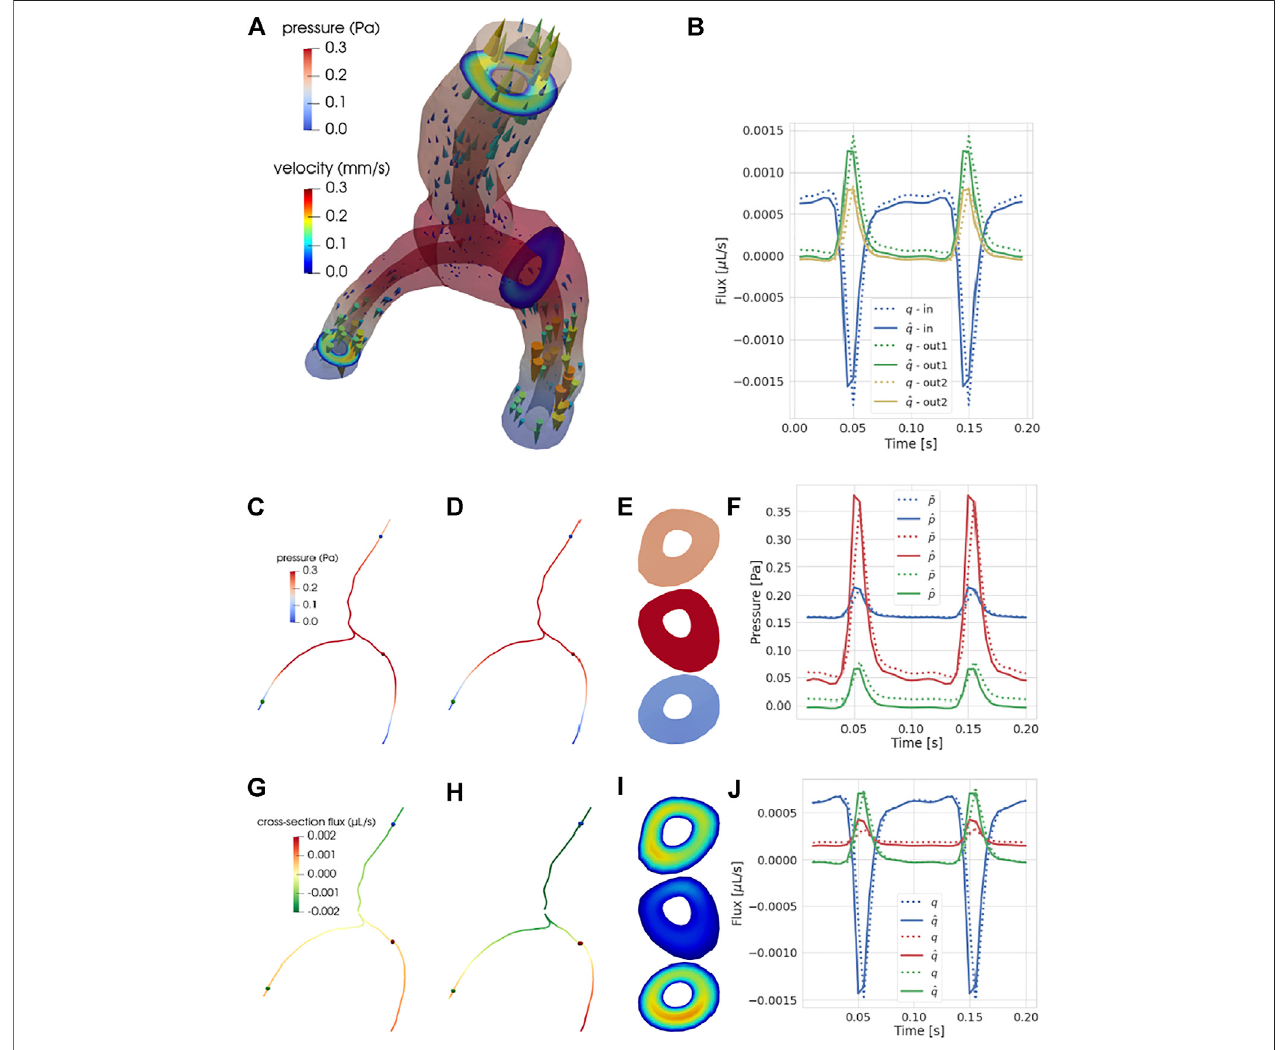
FIGURE 6 | Flow through a bifurcating PVS (Model C12) (A) Snapshot of pressure and velocity from full model at peak velocity ( t = 0.05). (B) Full versus reduced cross-section fl ux at inlet (in) and outlets (out1 and out2) over time. (C) Snapshot of reduced cross-section pressure at peak velocity. (D) Snapshot of average cross- section pressure at the same time. (E) Pressure at upper, middle and lower cross-sections [zoom of (A) ]. (F) Full versus reduced cross-section average pressure at cross-sections. (G) Snapshot of reduced cross-section fl ux at peak velocity ( t = 0.05). (H) Snapshot of cross-section fl ux from the full model at the same time. (I) Flux at upper, middle and lower cross-sections [zoom of (A) ]. (J) Full versus reduced cross-section fl ux at cross-sections.